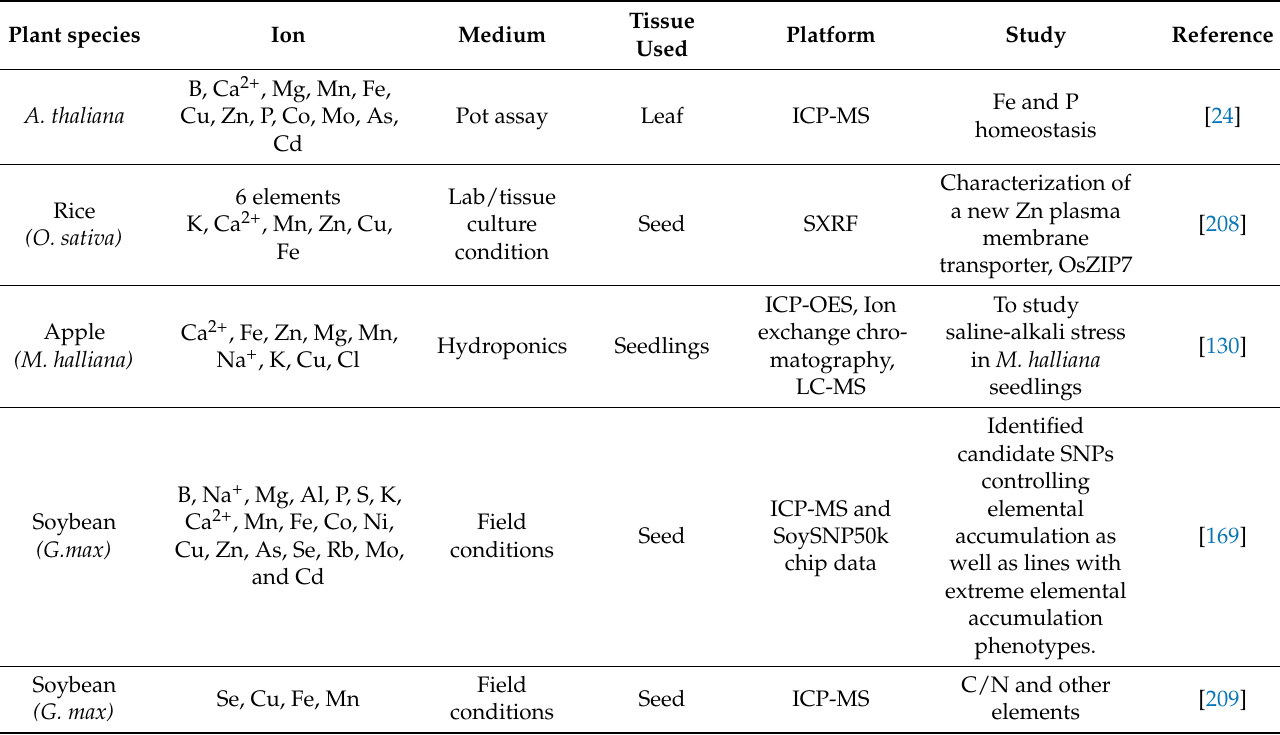
Table 4. Shows the high-throughput analytical techniques commonly used for ionomics in plants. Plant species Ion Medium